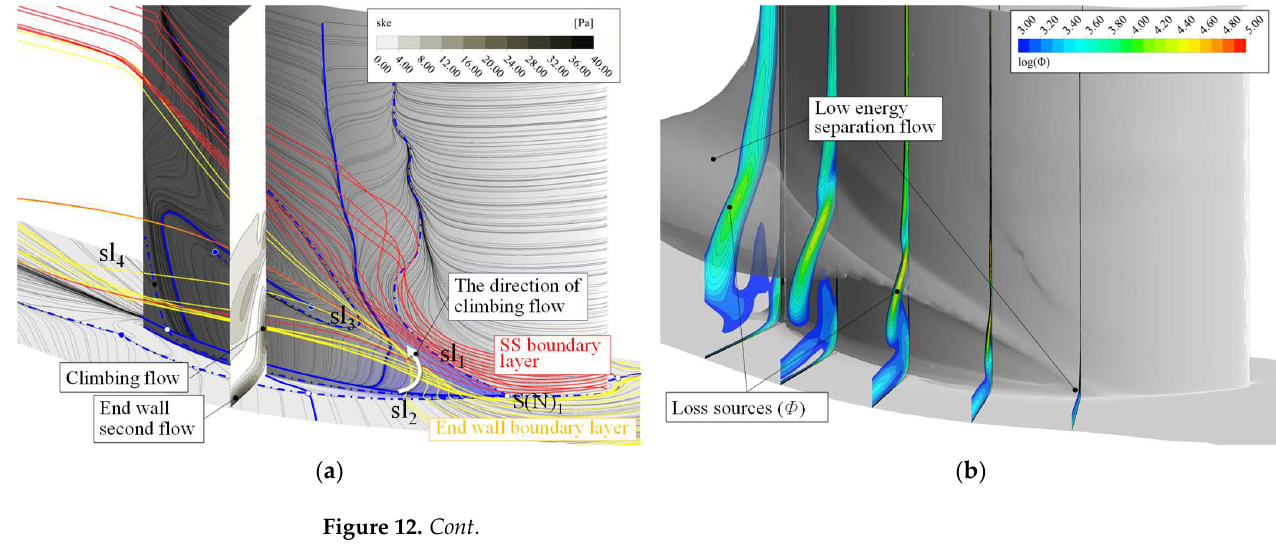
Figure 11. Pitch-averaged total pressure loss at 0.4 C a downstream of the TE. ( a ) At the design point ( i = −1°); ( b ) near-stall point ( i = 7°).